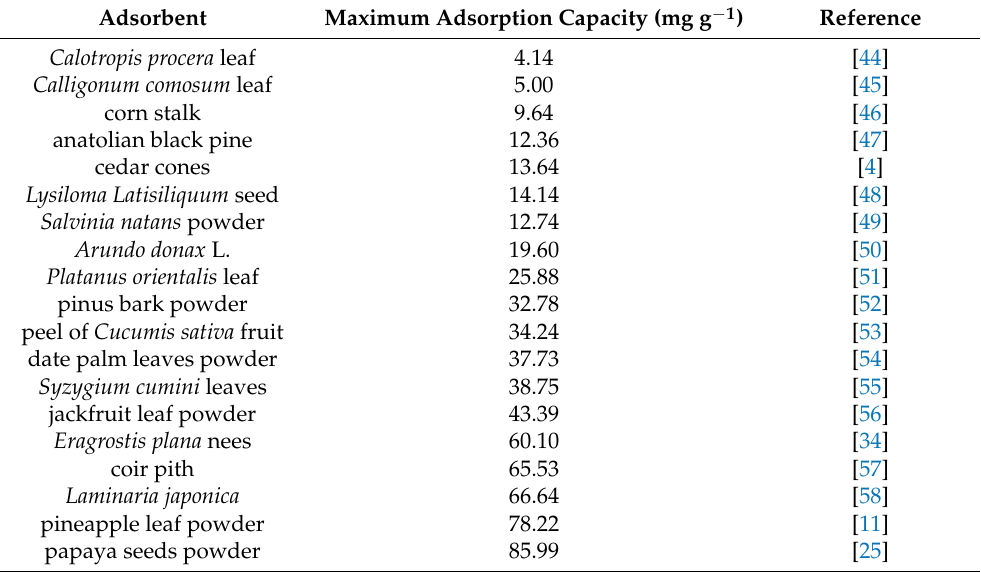
Table 2. The values of the maximum absorption capacities of some absorbents obtained from vegetable